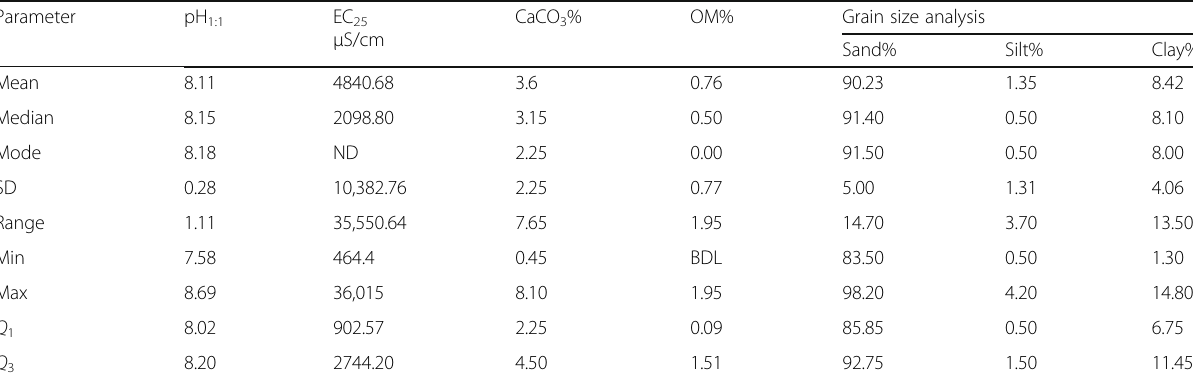
Table 2 Summary statistics of physicochemical parameters of soil samples in Orabi area Parameter